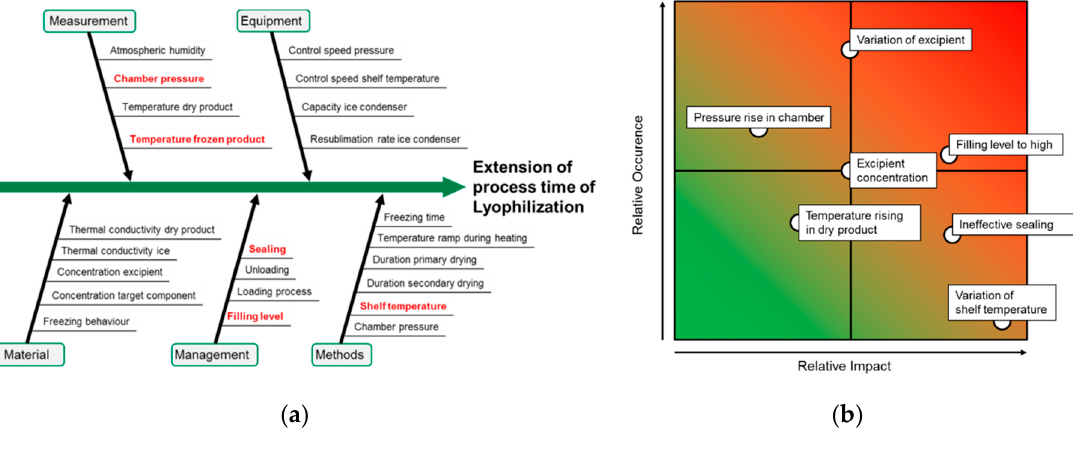
Figure 4. Part of the risk assessment for lyophilization: ( a ) Ishikawa diagram and ( b ) Occurrence-Impact diagram.